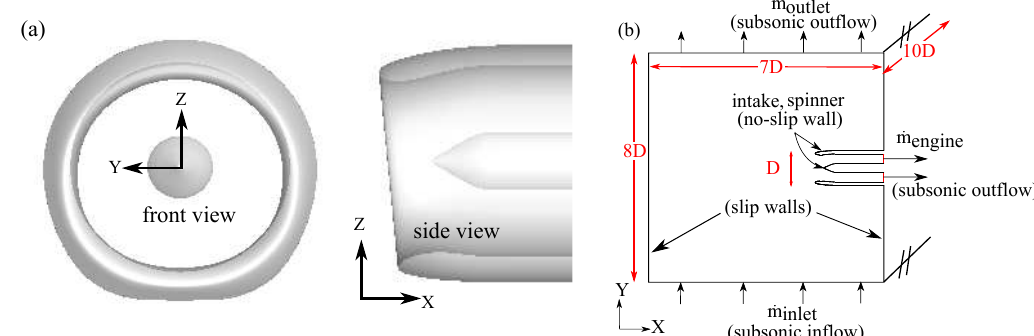
Figure 2. ( a ) Drooped intake geometry; ( b ) boundary conditions for full 3D